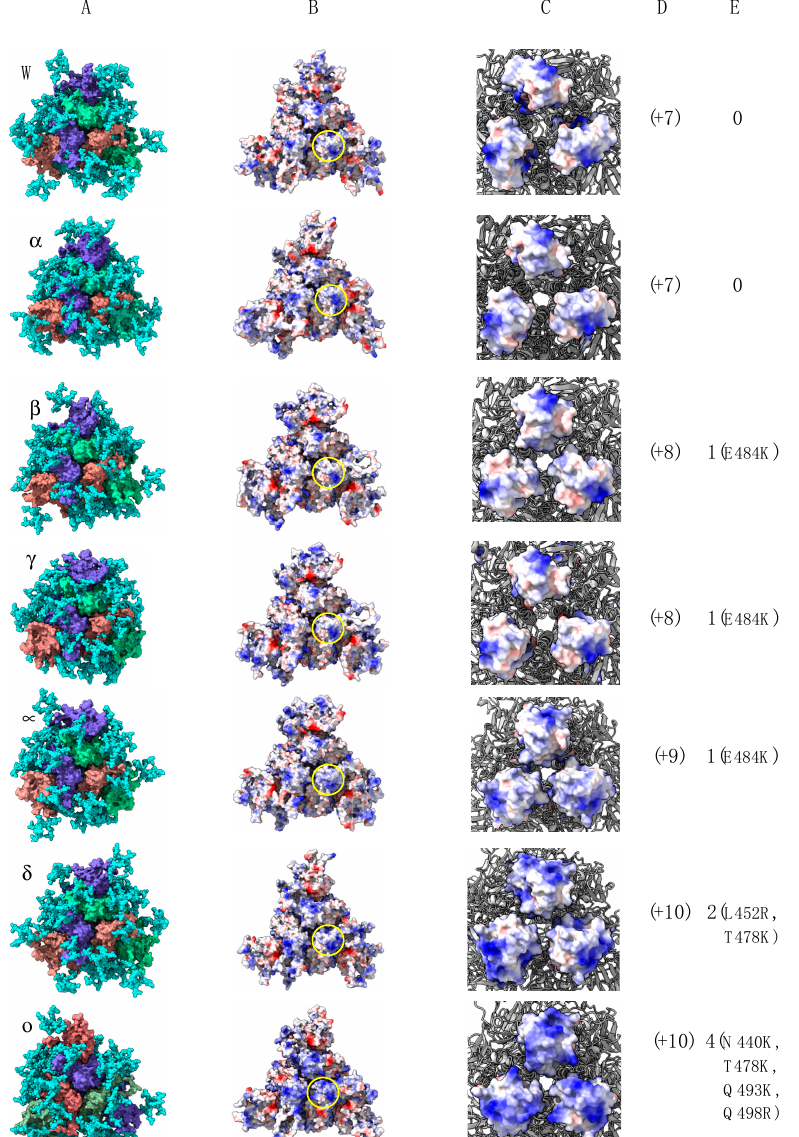
Figure 2. ( A ) row, from top to bottom: Overall three-dimensional structure of homotrimeric spikes of the Wuhan strain (W) and variants α (B.1.1.7), β (B.1.351), γ (P1), µ (B.1.621), δ (B.1.617.2) and o (B.1.1.529). The 3 monomers forming the spike homotrimer are differently colored in violet, red and green. The N -glycans decorating the spike are presented by cyan-colored balls. ( B ) row, from top to bottom: Calculated surface electrostatic potentials at the surface of spike homotrimers of the Wuhan strain (W) and variants α (B.1.1.7), β (B.1.351), γ (P1), µ (B.1.621), δ (B.1.617.2) and o (B.1.1.529). The yellow circle delineates the exposed surface of a spike RBD. ( C ) row, from top to bottom: enlarged views showing the distribution of surface electrostatic potentials at the exposed surface of the spike RBD. Electropositively and electronegatively charged surfaces are colored blue and red, respectively; neutral surfaces are colored white. ( D ) row, from top to bottom: calculated net charges and p I of RBD from homotrimeric spikes of the Wuhan strain (W) and variants α (B.1.1.7), β (B.1.351), γ (P1), κ (B.1.621), δ (B.1.617.2) and o (B.1.1.529). ( E ) row, from top to bottom: Number of point mutations generating electropositively charged residues, Arg (R) or Lys (K), which occurred in the RBD of homotrimeric spikes of the Wuhan strain (W) and variants α (B.1.1.7), β (B.1.351), γ (P1), μ (B.1.621), δ (B.1.617.2) and o (B.1.1.529).